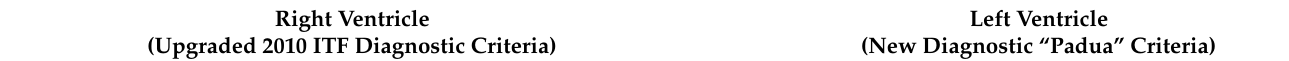
Table 1. Diagnostic criteria for diagnosis of arrhythmogenic